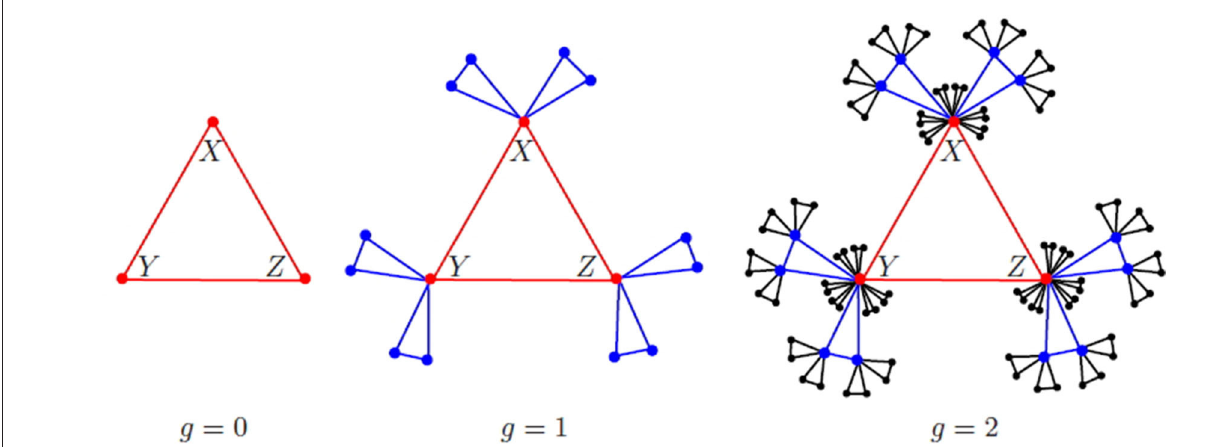
FIGURE 1 | The Koch networks for m = 2.